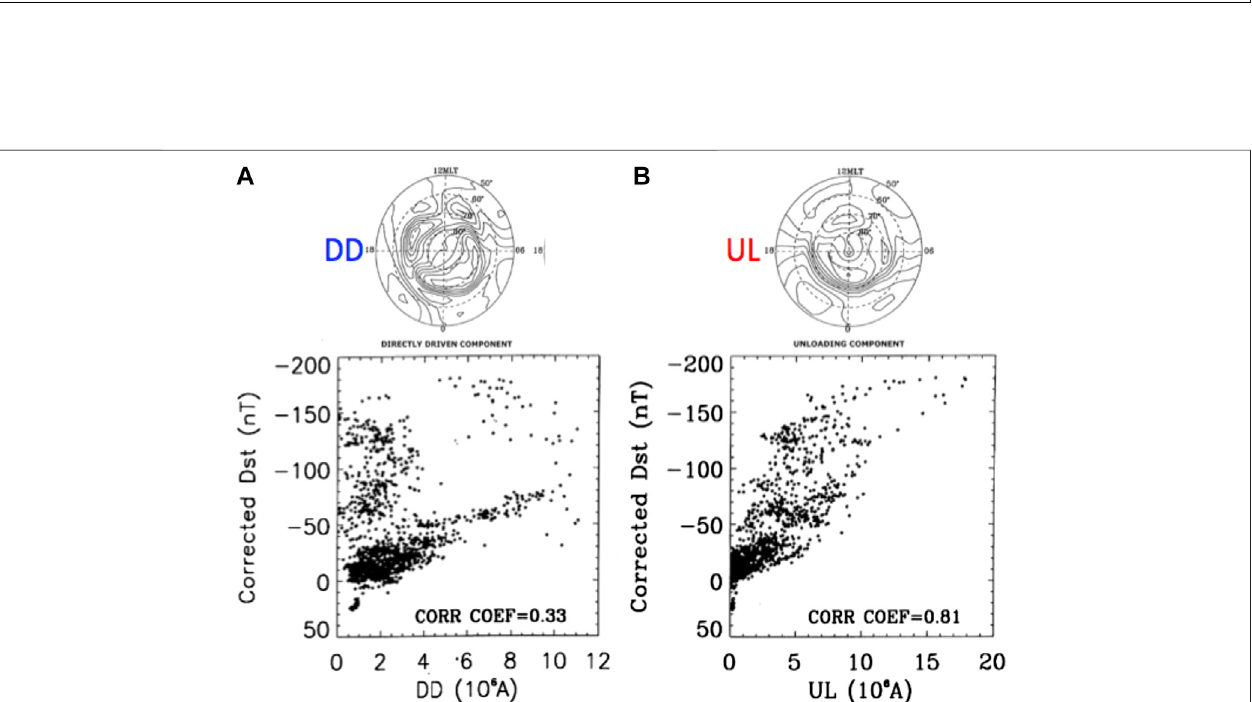
Frontiers in Astronomy and Space Sciences |